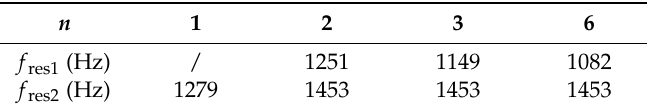
Table 2. The relationship between n and the resonant frequencies.